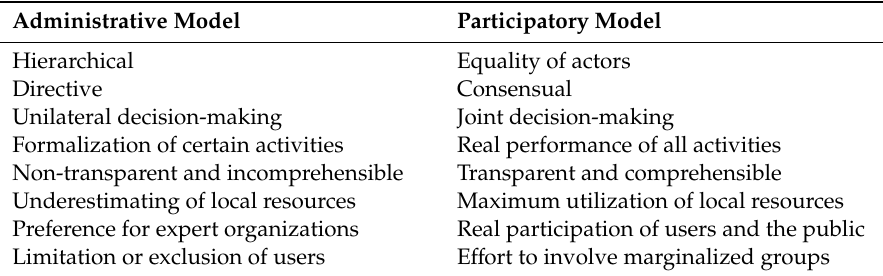
Table 2. Participatory vs. administrative model of community planning